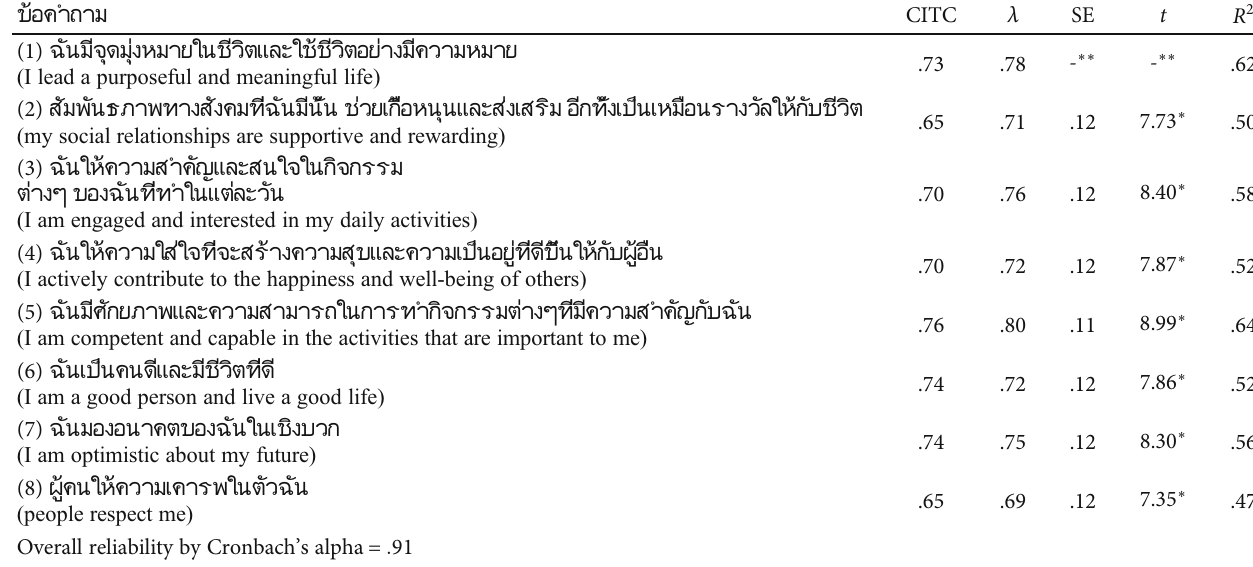
Table 1: Overview of the psychometric properties of the Thai version psychological well-being scale classi fi ed by each item.